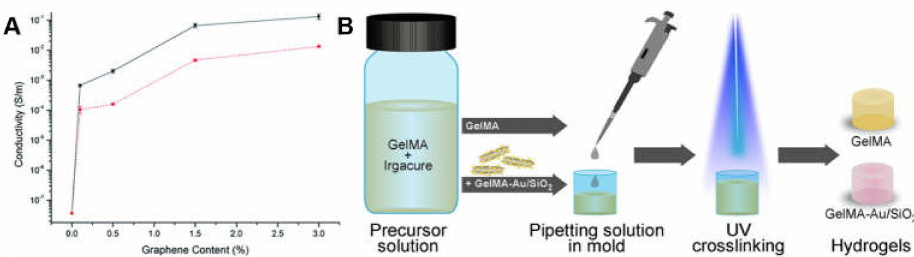
Figure 4. ( A ) Conductivity changes based on the graphene content of composite hydrogels produced using lactic acid (black) and acetic acid (red) [41]. Reprinted from [41] with permission from Royal Society of Chemistry. ( B ) A schematic showing the procedure for preparing composite conductive hydrogel [46]. Reprinted from [46] with permission from Elsevier.